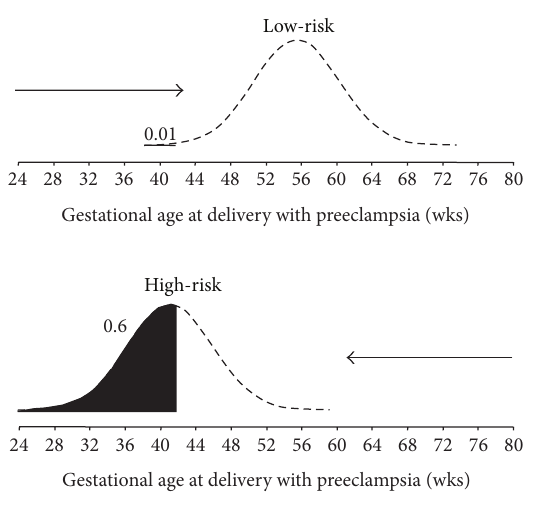
Figure 1: Distribution of gestational age at delivery for preeclampsia (PE). In pregnancies at low-risk for PE the gestational age distri- bution is shifted to the right and in most pregnancies delivery will occur before the development of PE. In pregnancies at high-risk for PE the distribution is shifted to the left. The risk of PE occurring at or before a specified gestational age is given by the area under the distribution curve (black). In the low-risk group the risk of PE at or before 34 weeks’ gestation is 0.01 or 1% and in the high-risk group the risk is 0.6 or